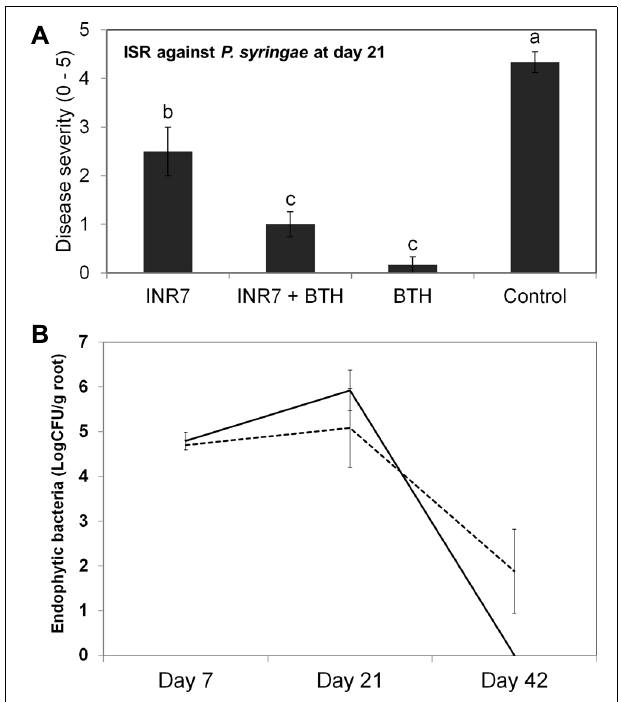
FIGURE 6 | Induction of systemic resistance by B. pumulis INR7 and benzothiadiazol and population change by BTH treatment in tobacco under field conditions. (A) Induction of plant resistance against a compatible P. syringae pv. tabaci. Disease severity was measured 21 days after infilteration of P. syringae pv. tabaci at 10 6 cfu/ml in plants pretreated with bacterial suspension of strain INR7 (INR7), 0.5 mM BTH (BTH), and the combination (INR7 + BTH). Bars represent the mean ± SE (sample size, N = 40 replications per treatment). Different letters indicate significant differences between treatments ( P = 0.05 according to least significant difference). (B) Endophytic population dynamics of B. pumilus INR7 with and without 0.5 mM BTH treatment. Bacterial populations of spontaneous rifampicin resistant B. pumilus INR7 were quantified at the day of application on pepper roots and 0, 7, 21, and 42 days after the application. Bars represent mean ±